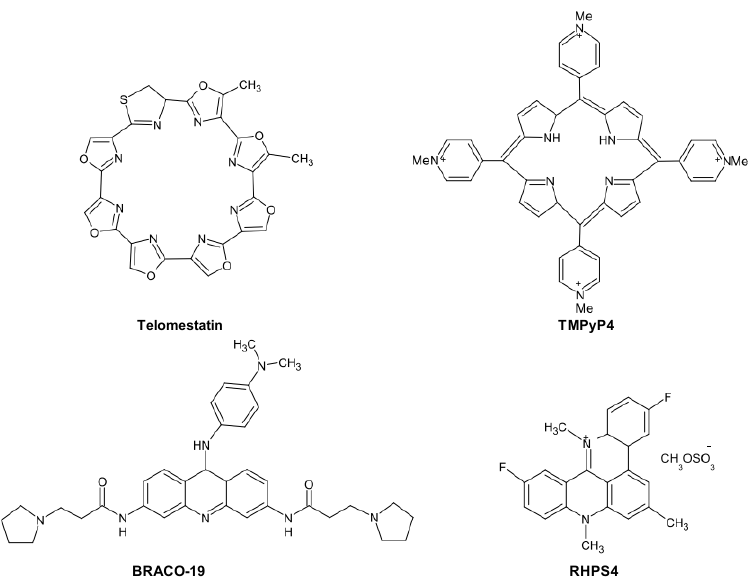
Figure 2. Chemical structures of historical telomeric G4-stabilizing